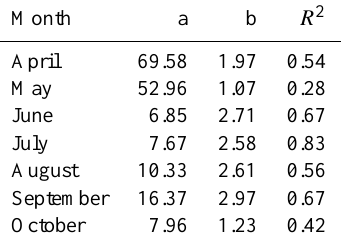
Table 2. Coefficients a and b used in Eq. (4) to estimate the total burned area by month as a function of MSR averaged over the whole of Finland. R 2 is the coefficient of